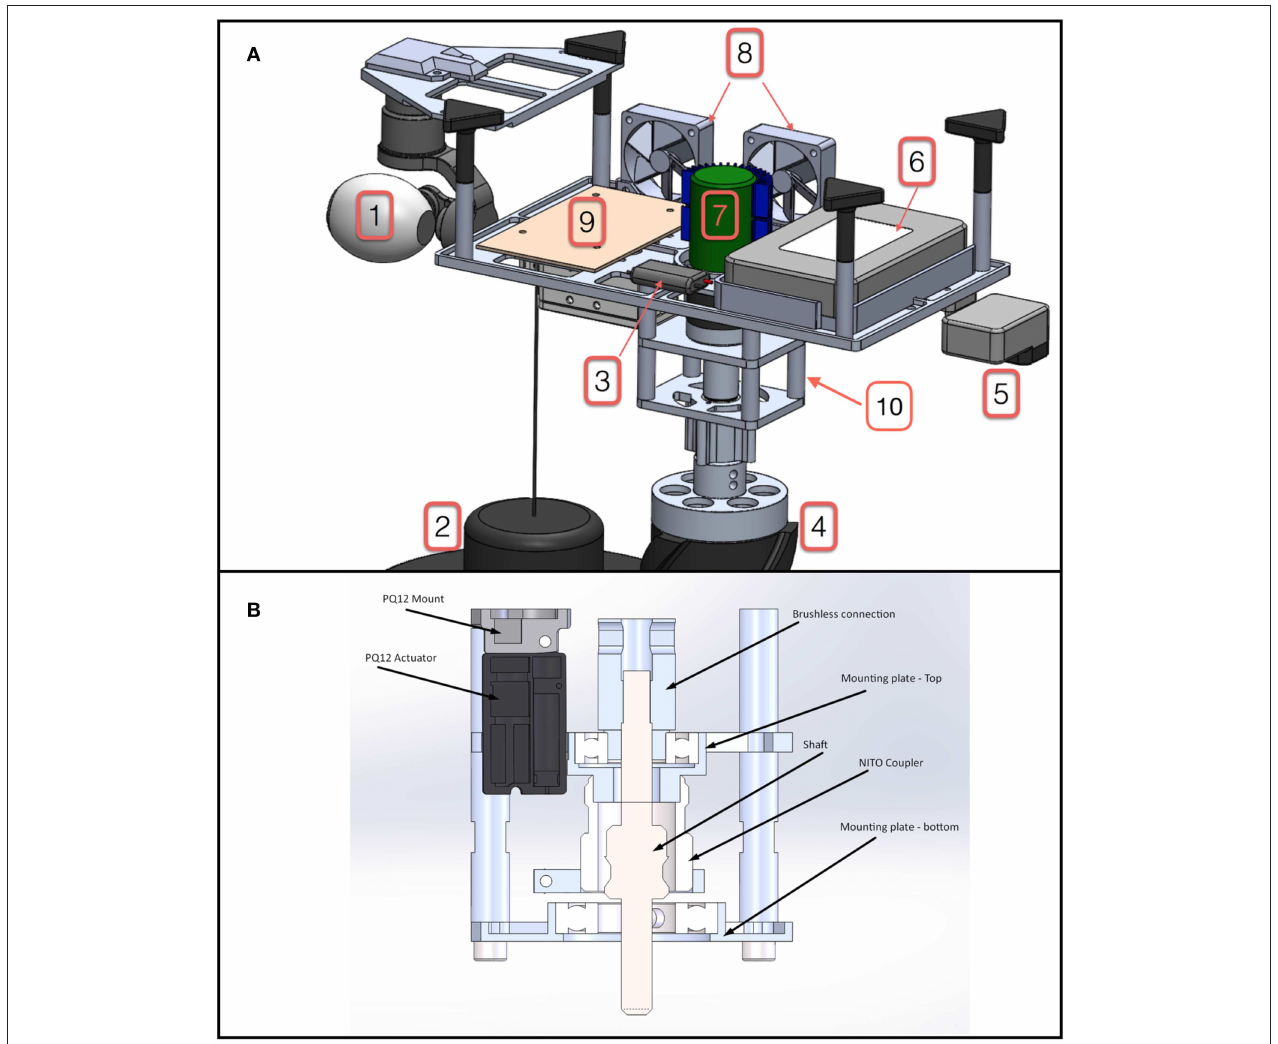
FIGURE 6 | (A) The mounting plate for the electronics with the following components labeled: 1. Zenmuse X3 camera; 2. GPS tracker suspended from release mechanism; 3. electronic speed controller for the brushless motor; 4. drill ( Figure 2 ); 5. optional thermal camera mount; 6. myRIO; 7. brushless motor; 8. cooling fans; 9. Bracket for 3S 4000 mAh LiPo battery; 10. Mounting plate for brushless motor connection to the drill shaft. (B) Cross-sectional view of the quick-release mechanism that uses a NITO coupler that is moved by a linear